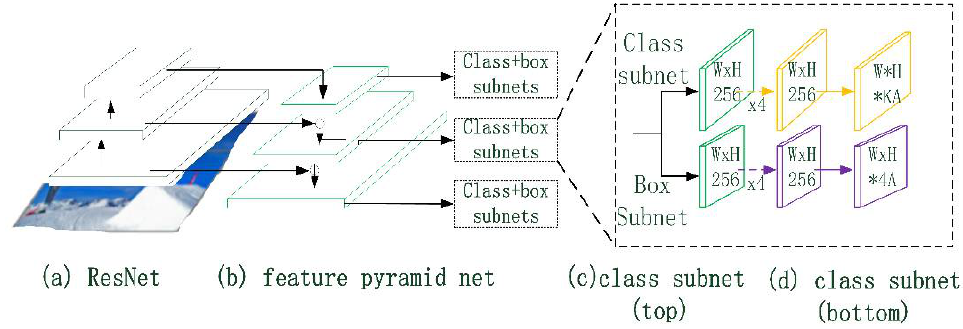
Figure 9. RetinaNet Network Structure.